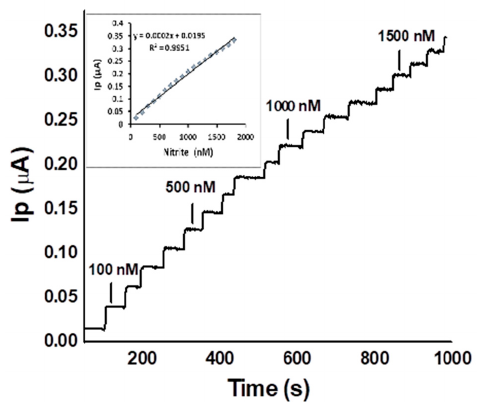
Figure 8. Amperometric (current vs. time) calibration curve recorded at applied potential of 1.0 V for nitrite detection in the range 100–1500 nM with inset showing the respective linear plot.